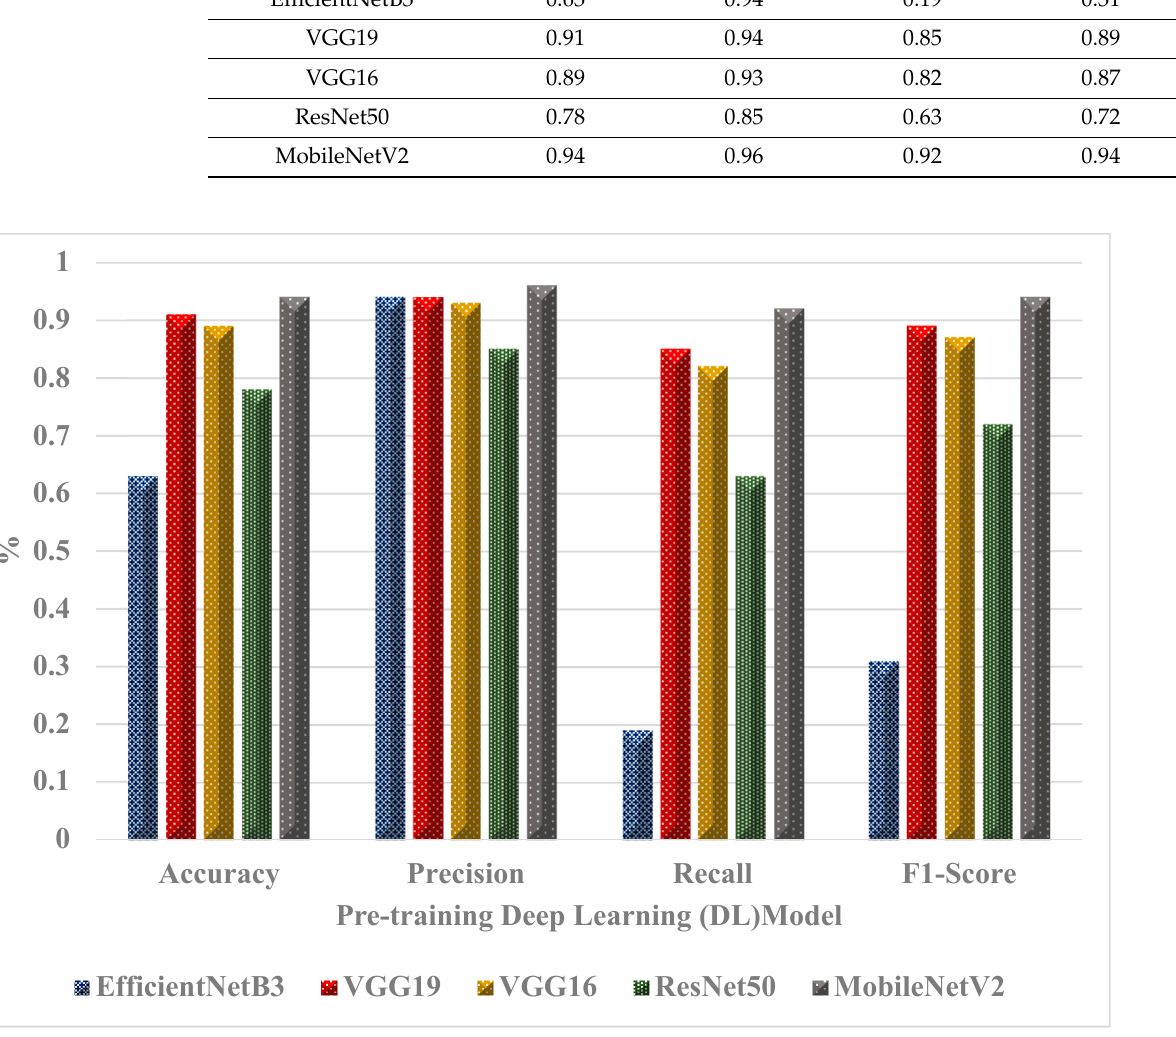
Figure 8. Performance of the classifier models.